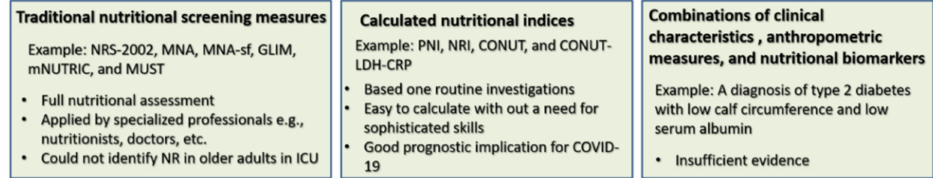
Figure 1. Schematic summary comparing different measures used for nutritional assessment in COVID-19 patients. NRS-2002: Nutrition Risk Screening 2002, GLIM: Global Leadership Initiative on Malnutrition, mNUTRIC: modified Nutrition Risk in the Critically ill, MNA-sf: Mini Nutrition Assessment Shortcut, MUST: Malnutrition Universal Screening Tool, NRI: Nutrition Risk Index, PNI: Prognostic Nutritional Index, CONUT: Controlling Nutritional Status, LDH: lactate dehydrogenase, CRP: C-reactive protein, ICU: intensive care unit, NR: nutrition